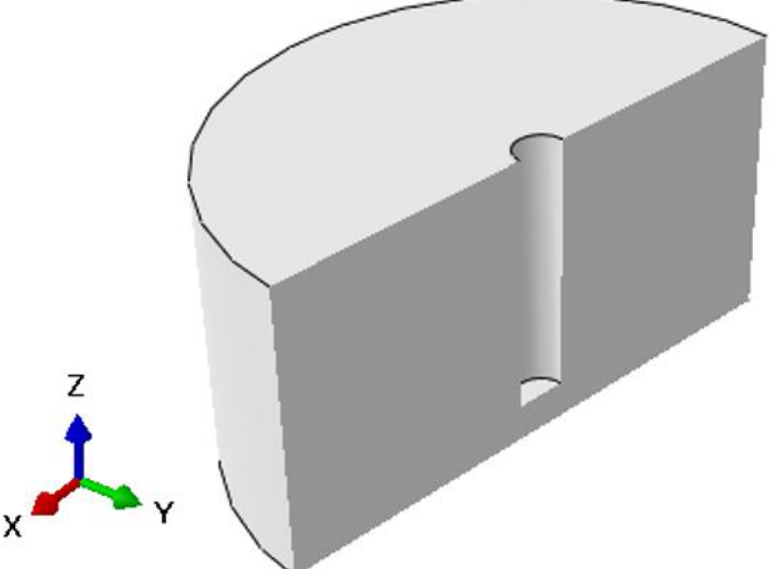
Figure 3. Soil 3D model. For the side interaction, the normal behaviour has been used as “hard” contact and the separation after contact (when loads are applied) is allowed. A cohesive behaviour has also been defined for the monopile. The tangential behaviour is used as a penalty, and a friction coefficient of 0.5 has been used [77]. A small sliding formulation has also been used. For the second interaction, the normal behaviour is still used as “hard” contact but the tangential is used as frictionless and a finite-sliding formulation is used. It has been decided to “tie” the bottom of the monopile with the